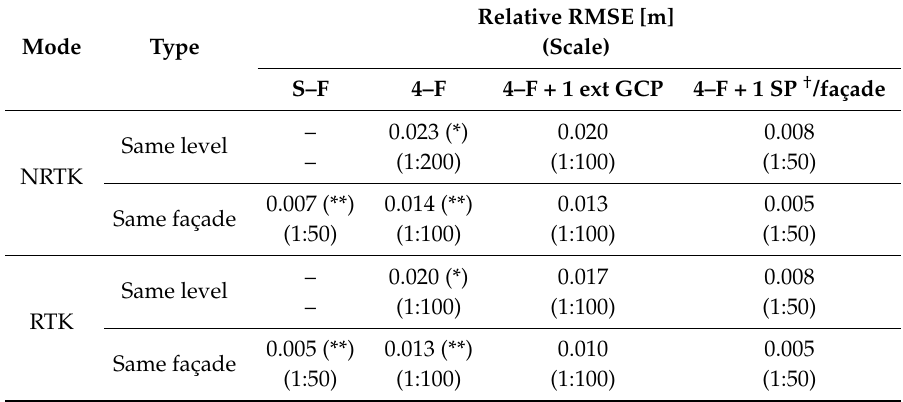
Table 12. Relative RMSE for different bias-fixing strategies. The scale whose metric survey specifications were satisfied is also reported in